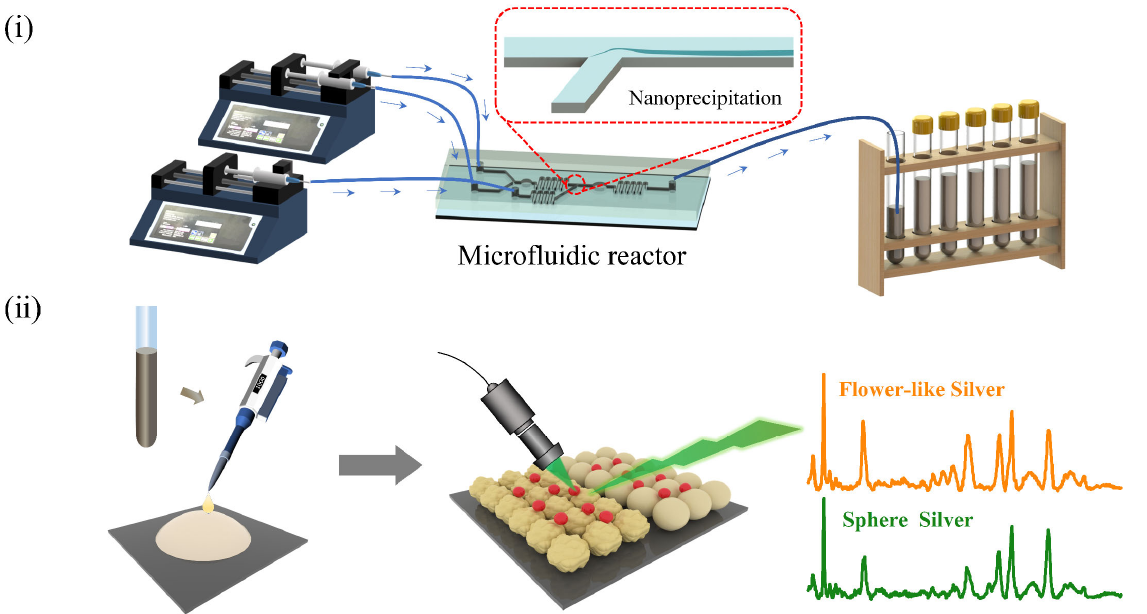
Figure 1. A schematic diagram of the device for fabricating submicron silver particles in a microfluidic chip and the synthesized silver particles that were used for SERS detection. ( i ) Microreactor part: the three-phase solution was pumped into the microchip for the reaction to occur and generate particles, collected in the test tube; ( ii ) SERS detection part: the synthesized particles were used as SERS substrates for SERS detection to evaluate their Raman enhancement effect.